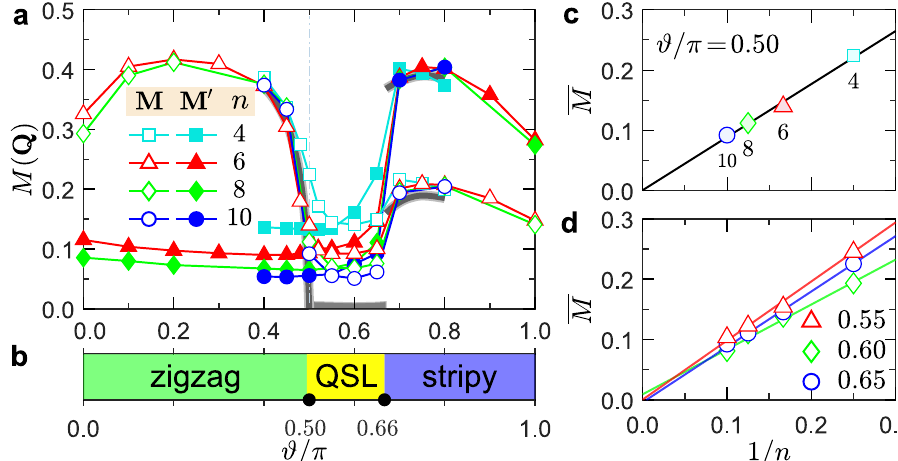
Fig. 5 Magnetic order parameters and quantum phase diagram. a Magnetic order parameters M ( Q ) for the zigzag order (open symbols) and stripy order ( fi lled symbols) with Q = M and/or M 0 under four fi nite XC clusters. The thick gray line shows the magnetic order in the thermodynamic limit. b Quantum phase diagram of the bond-modulated ~ J – Γ model. c , d Extrapolations of the maximal peaks M throughout the reciprocal space. c Linearly extrapolation for Γ model with ϑ / π = 0.50. d ϑ / π = 0.55 (red triangle), 0.60 (green diamond), and 0.65 (blue circle), respectively.